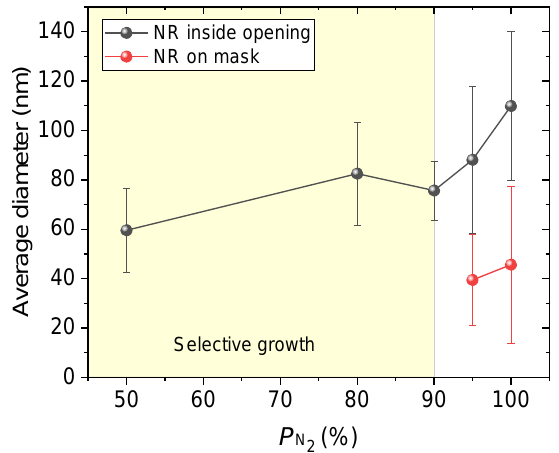
Figure 3. Average diameters of the NRs grown inside the openings and on the mask for growth with different Ar percentage in the total process